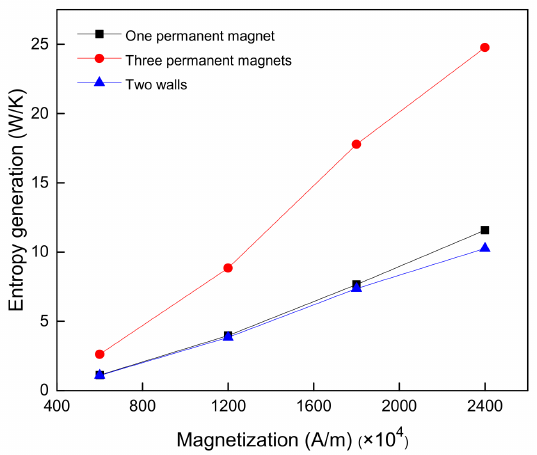
Figure 14. Entropy generation for magnetization at three